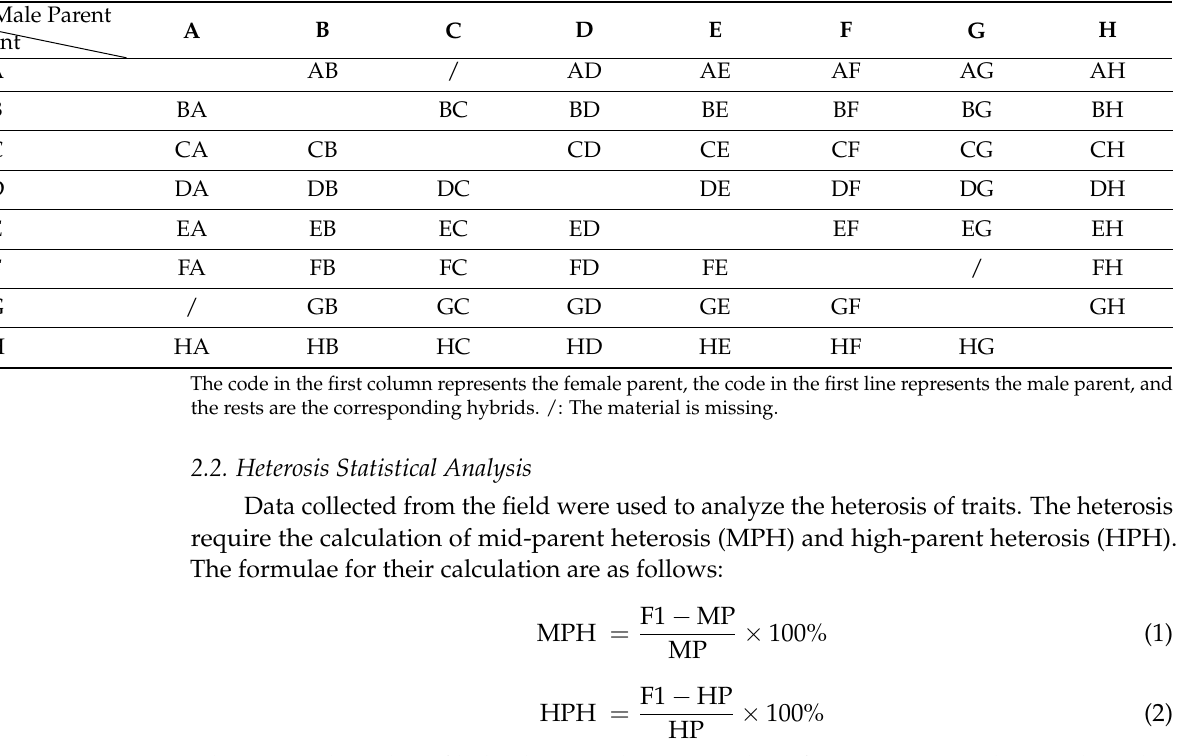
Table 1. The codes of inbred lines and hybrids of Chinese